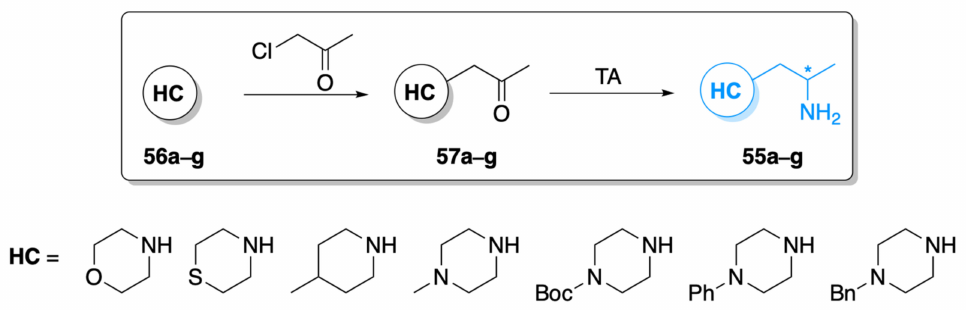
Figure 12. General reaction scheme for the synthesis of the target chiral 3D amine